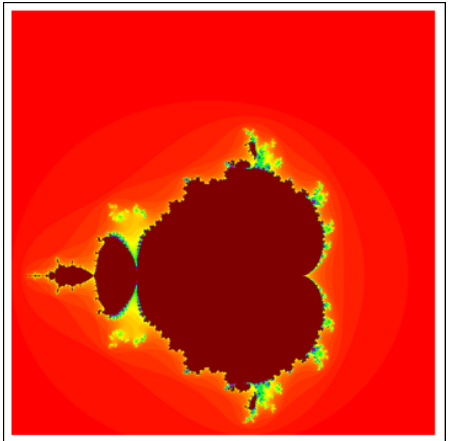
Figure 29. Quadratic M-set via F-iteration with image visual time = 118.7 s.